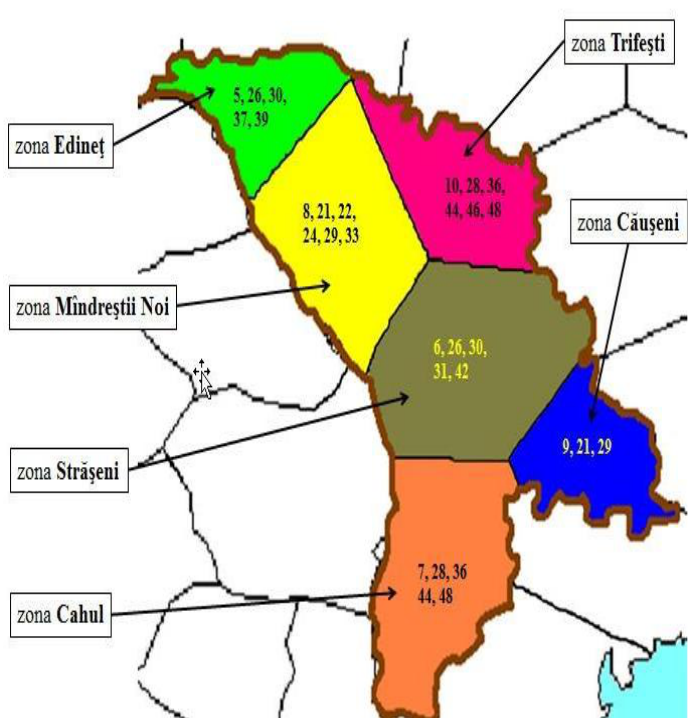
Figure 2. Location of national digital terrestrial television areas in the Republic of Moldova